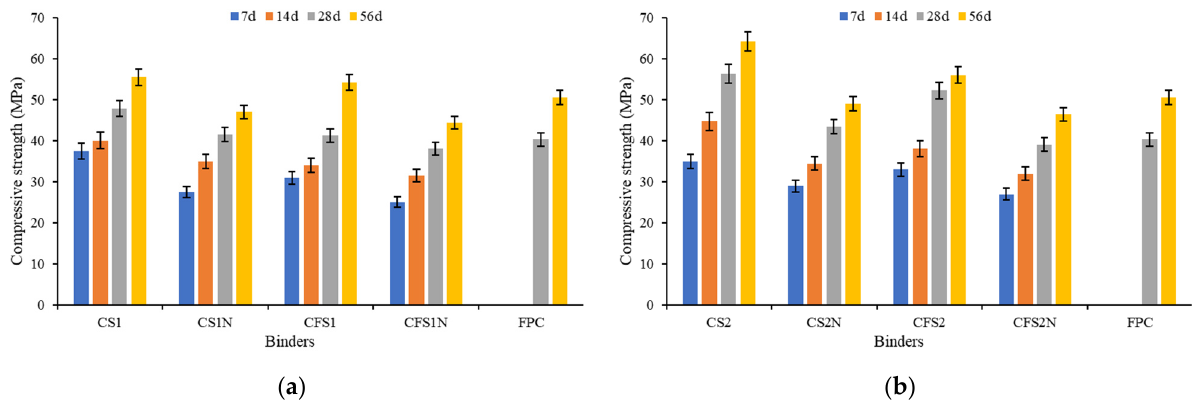
Figure 4. Compressive strength of binders with age: ( a ) influence of reagent 1, ( b ) influence of reagent 2.